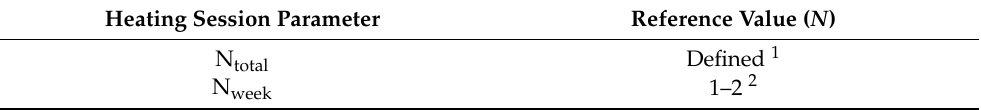
Table 5. Reference HT treatment session parameters. N : positive constant value.